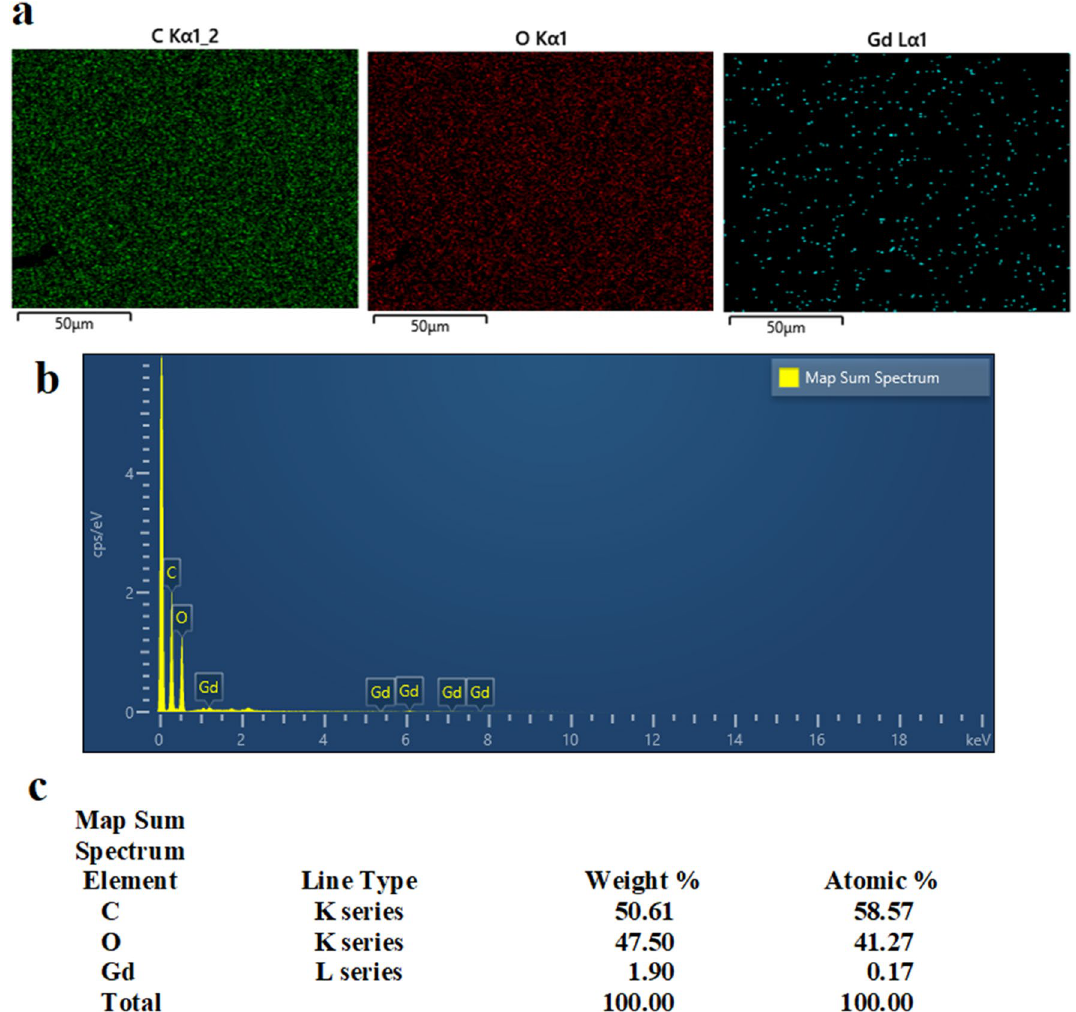
Figure 4. EDS analysis of the synthesized CQDs, ( a ) map of C, O, and Gd, ( b ) EDS map sum spectrum of the elements in the CQDs sample, ( c ) weight and atomic percent of the elements in the